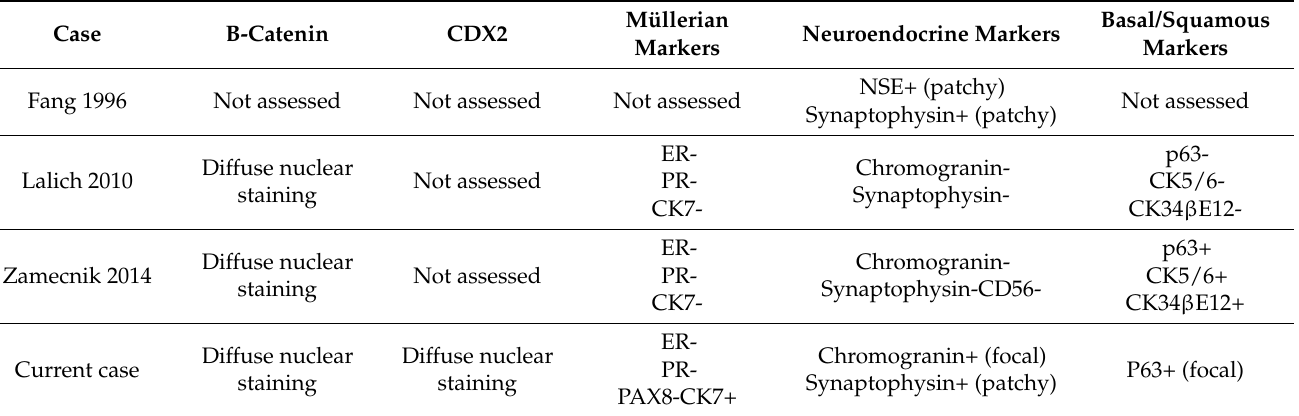
Table 2. Immunohistochemical features of the current case and previously published cases of putative ovarian